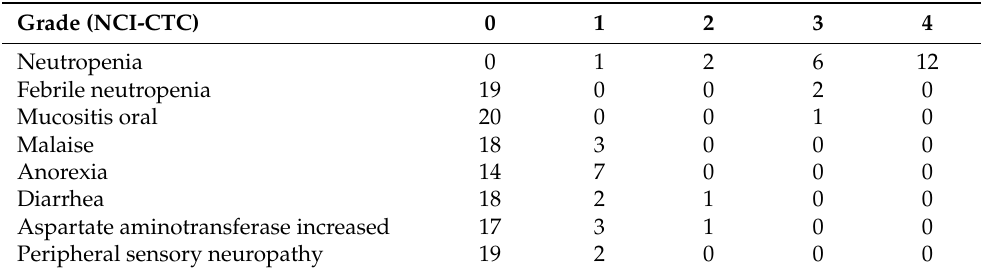
Table 3. Peri-operative toxicities according to grade during neoadjuvant chemohormonal therapy ( n = 21).